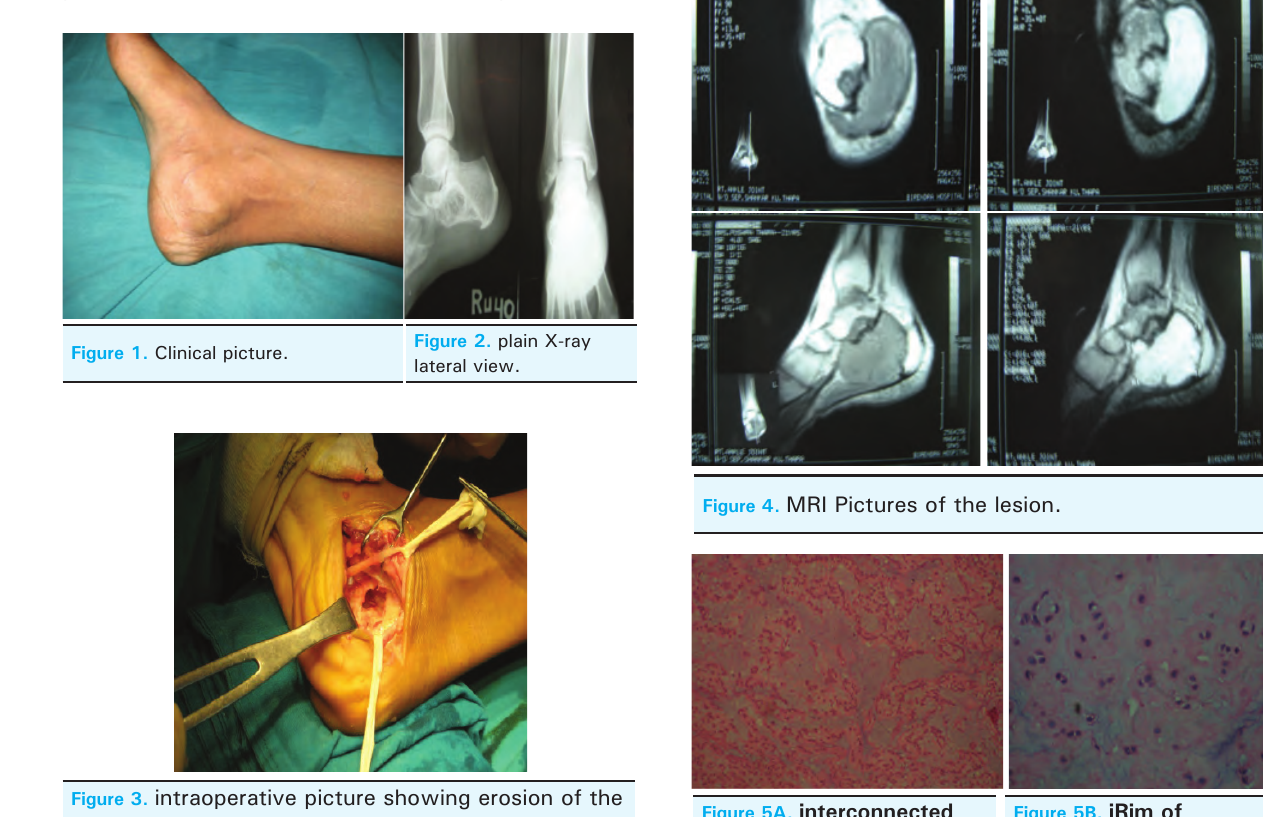
Figure 5B. irim of eosinophilic cytoplasm surrounding loosly clustered tumor cells with hyperchromatic nuclei floating in myxoid